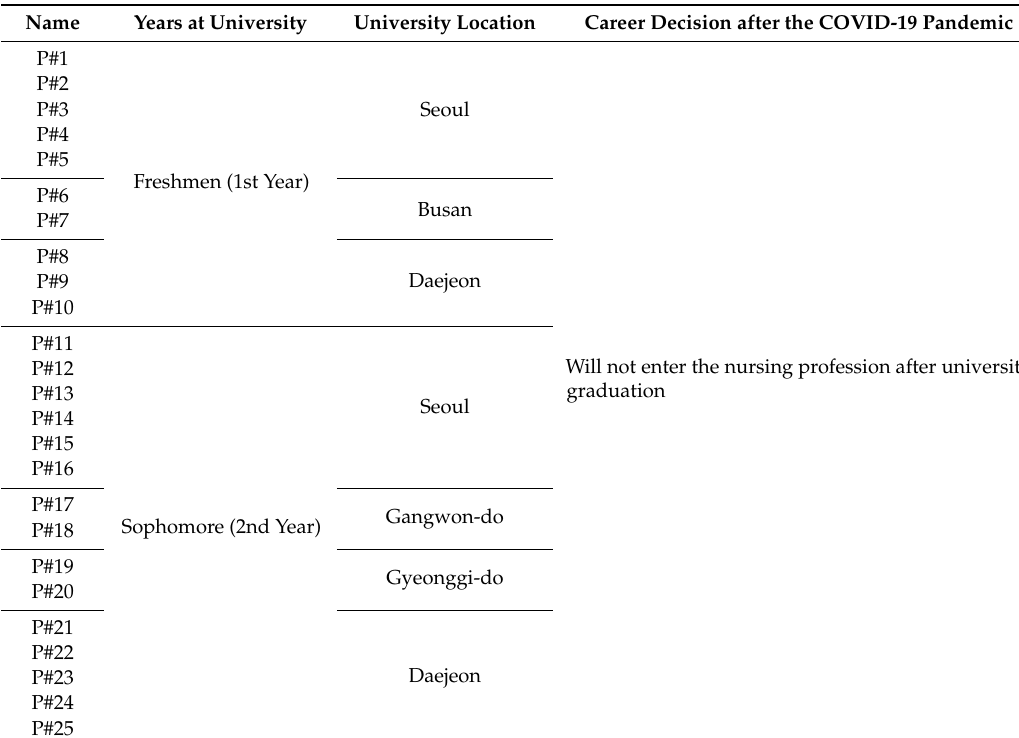
Table A1. Demography of the